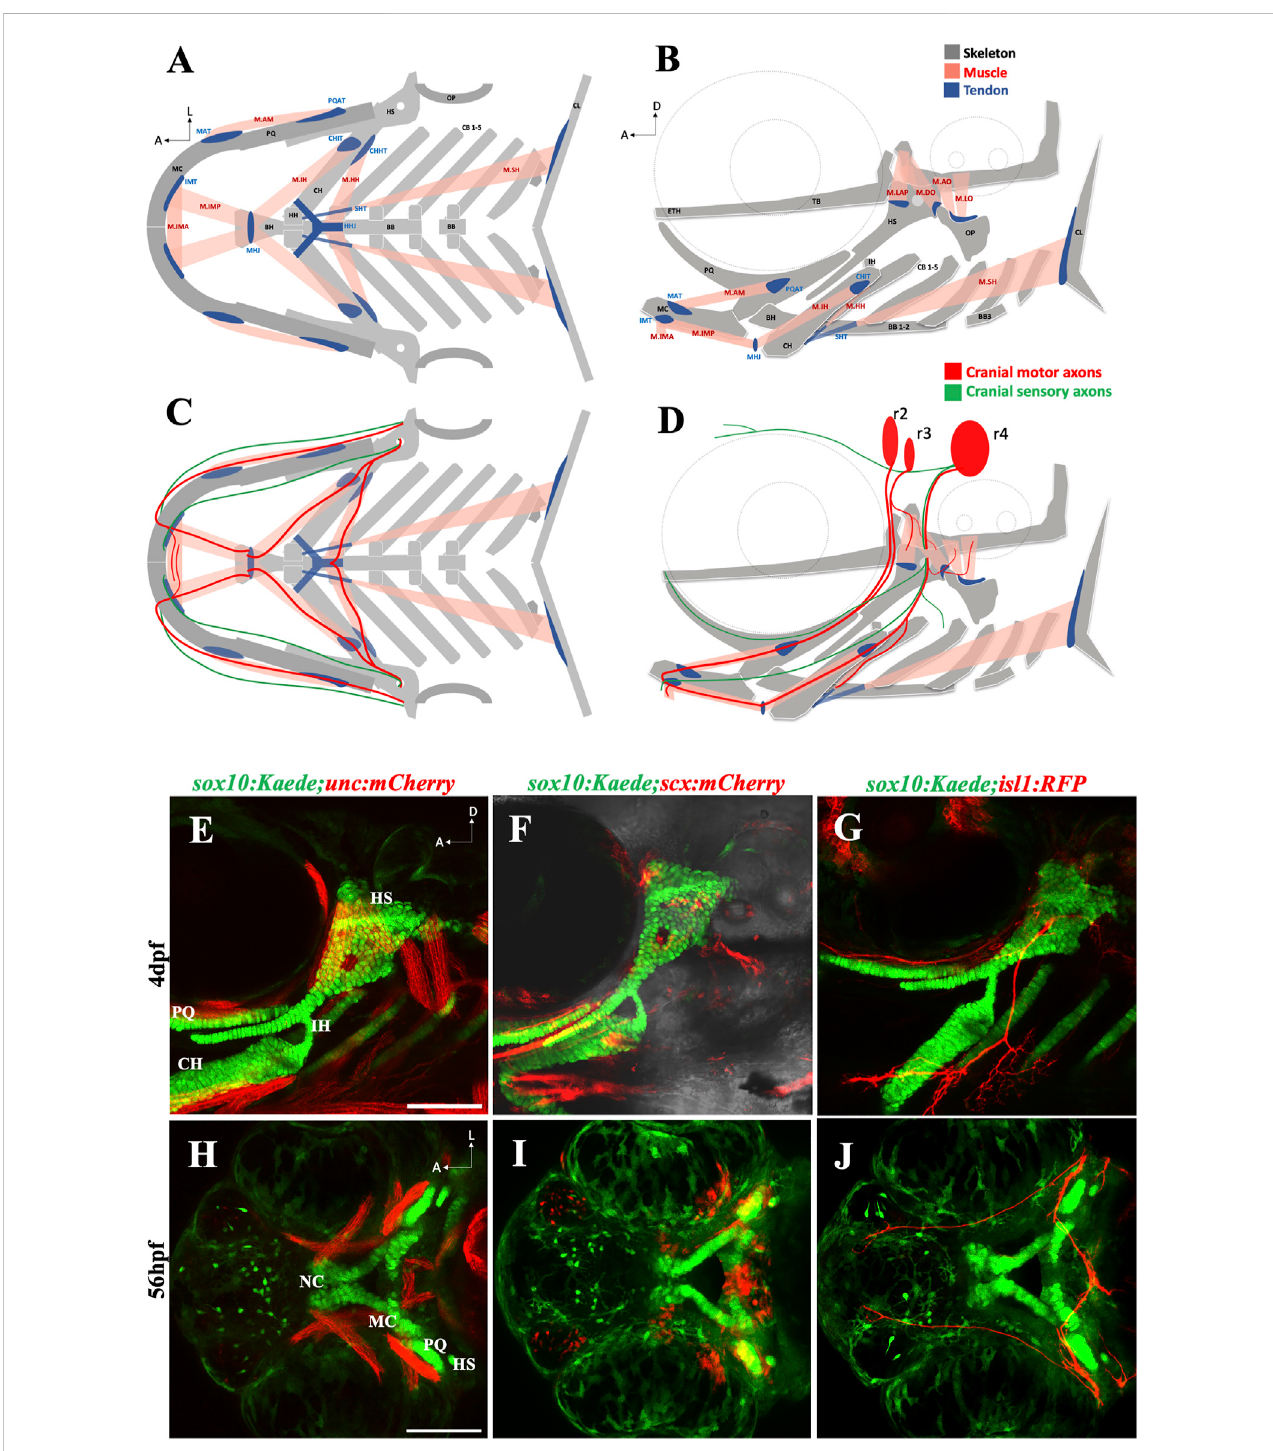
FIGURE 1 The zebra fi sh head has a complex anatomical organization (A, B) Schematics showing arrangement of craniofacial skeleton, muscle, and tendon in ventral and lateral planes (adapted from Schilling and Kimmel, 1997). (C, D) Schematics showing cranial nerves originating from rhombomere (r) 2, 3 & 4 innervating the branchial muscles in ventral and lateral planes. (E) 4dpf sox10:Kaede;unc:mCherry double transgenic fi sh showing musculoskeletal arrangement laterally. (F) 4dpf sox10:Kaede;scx:mCherry double transgenic fi sh showing tendons and cartilage laterally. (G) 4dpf sox10:Kaede;isl1:RFP double transgenic fi sh showing branchiomotor neurons and cartilage laterally. (H – J) Ventral view of developing zebra fi sh head at 56hpf showing craniofacial cartilage, muscle, tendons, and motor neurons emerge and integrate around the same developmental window. A (anterior), D (dorsal) L (lateral). r (rhombomere). Skeleton (grey) — BB (basibranchial), BH (basihyal), CB (ceratobranchial), CH (ceratohyal), CL (cleithrum), ETH (ethmoid), TB (trabecula), HH (hypohyal), HS (hyosymplectic), MC (Meckel ’ s cartilage), OP (opercle), PQ (palatoquadrate). Tendon (blue) — CHHT (ceratohyal hyohyoideus tendon), CHIT (ceratohyal interhyoideus tendon), HHJ (hyohyal junction), IMT (intermandibular tendon), MAT (Meckel ’ s adductor tendon), MHJ (mylohyoid junction), PQAT (palatoquadrateadductor tendon),SHT (sternohyoideus tendon). Muscle(pink) — M.AM (adductormandibularismuscle),M.AO(adductoroperculimuscle),M. DO(dilatoroperculimuscle),M.HH(hyohyoideusmuscle),M.IH(interhyoideusmuscle),M.IMA(Intermandibularisanteriormuscle),M.IMP(Intermandibularis posterior muscle), M. LAP (levator arcus palatini muscle), M. LO (levator operculi muscle), M. SH (sternohyoideus muscle). Scale bar = 100